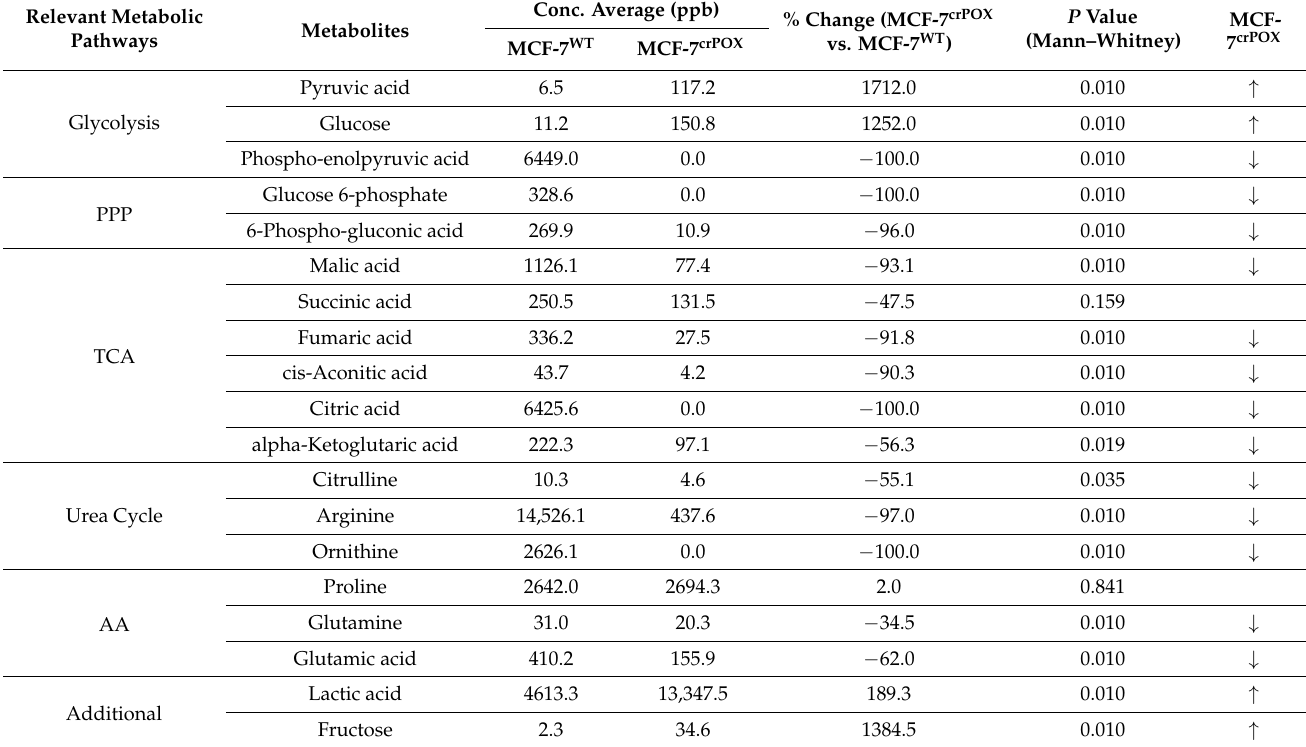
Table 1. Targeted metabolic profiles of some metabolites of glycolysis, pentose phosphate pathway, TCA and urea cycles in